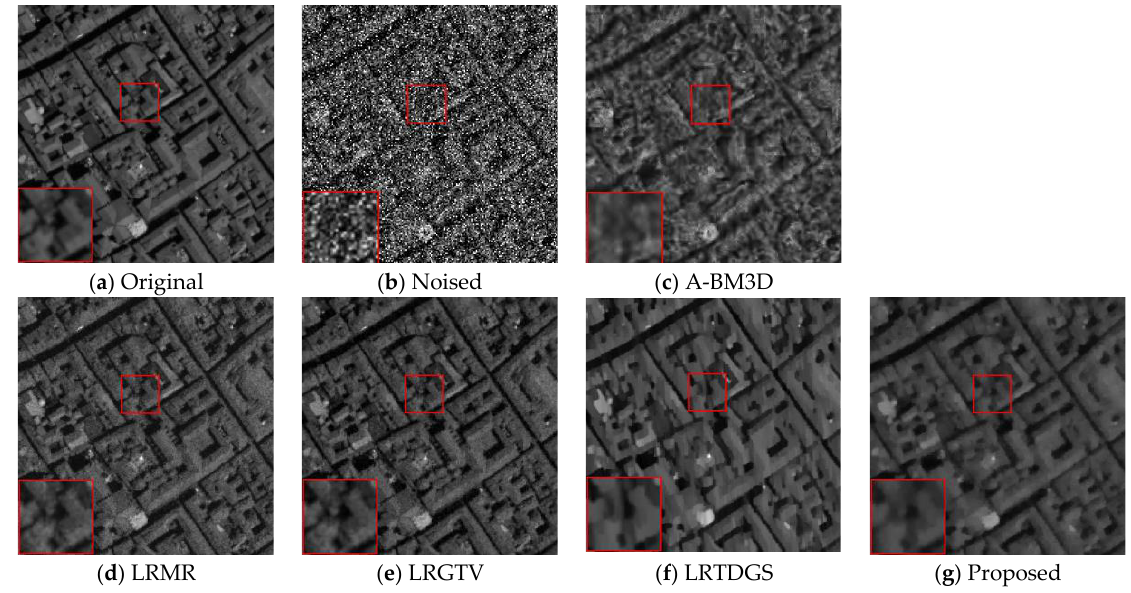
Figure 4. Restored results of band 57 on Pavia. From top to bottom: the results under a subcase (the standard deviation of zero-mean Gaussian noise is G = 0.10, and the noise proportion of S&P noise is S = 0.20).